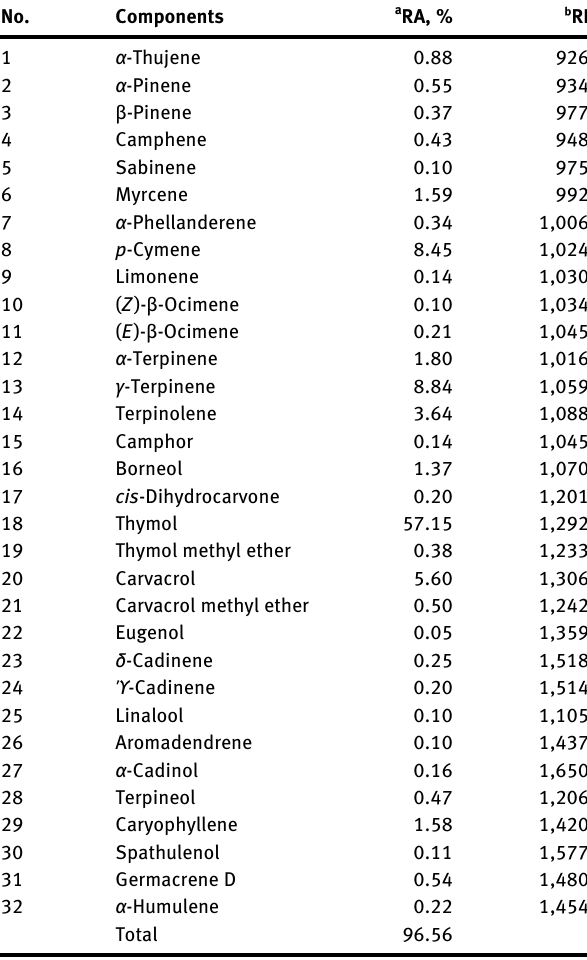
Table  : Chemical composition of essential oil of Thymus vulgaris analysed by GC-MS (gas chromatography-mass spectrometry) from Pakistan.